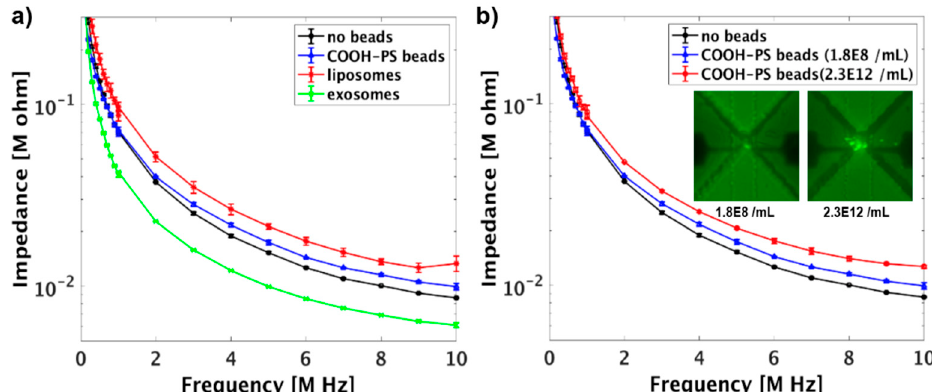
Figure 6. ( a ) The impedance of different particles suspended in electrolytic (10 mM KCl) solution as a function of frequency. The initial concentration of the COOH-PS beads was 1.8 × 10 8 /mL. ( b ) The impedance of the COOH-PS beads with different initial concentrations suspended in 10 mM KCl solution. The error bars represent the standard deviation and each experiment was repeated at least three times.